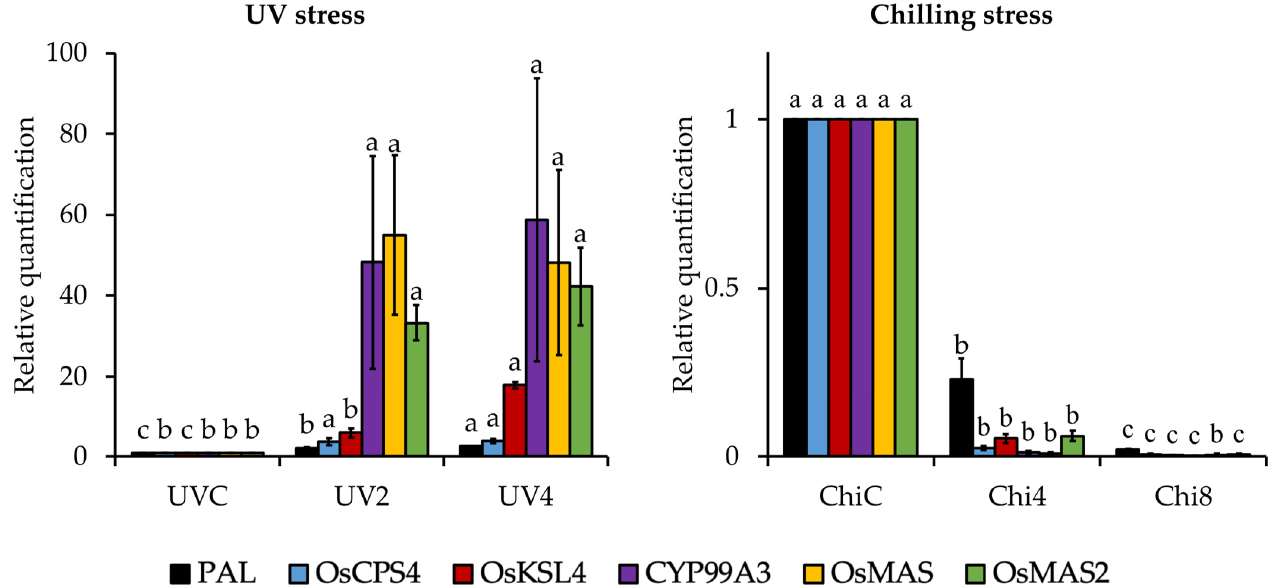
Figure 1. Expressions of relevant genes to the biosynthesis of phenolics and momilactones in rice seedlings against UV and chilling stresses. UVC, control rice seedlings without UV treatments; UV2, UV-treated rice seedlings for 2 h per day; UV4, UV-treated rice seedlings for 4 h per day; ChiC, control rice seedlings without chilling treatments; Chi4, chill-treated rice seedlings for 4 h per day; Chi8, chill-treated rice seedlings for 8 h per day; PAL , gene encoding phenylalanine ammonia-lyase; OsCPS4 , gene encoding syn-copalyl diphosphate synthase-like; OsKSL4 , gene encoding syn-pimara- 7,15-diene synthase-like; CYP99A3 , gene encoding 9-beta-pimara-7,15-diene oxidase-like; OsMAS , gene encoding momilactone A synthase-like; OsMAS2 , gene encoding momilactone A synthase-like. Different letters (a,b,c) enclosed with columns (same colors) express significant differences at p < 0.05.